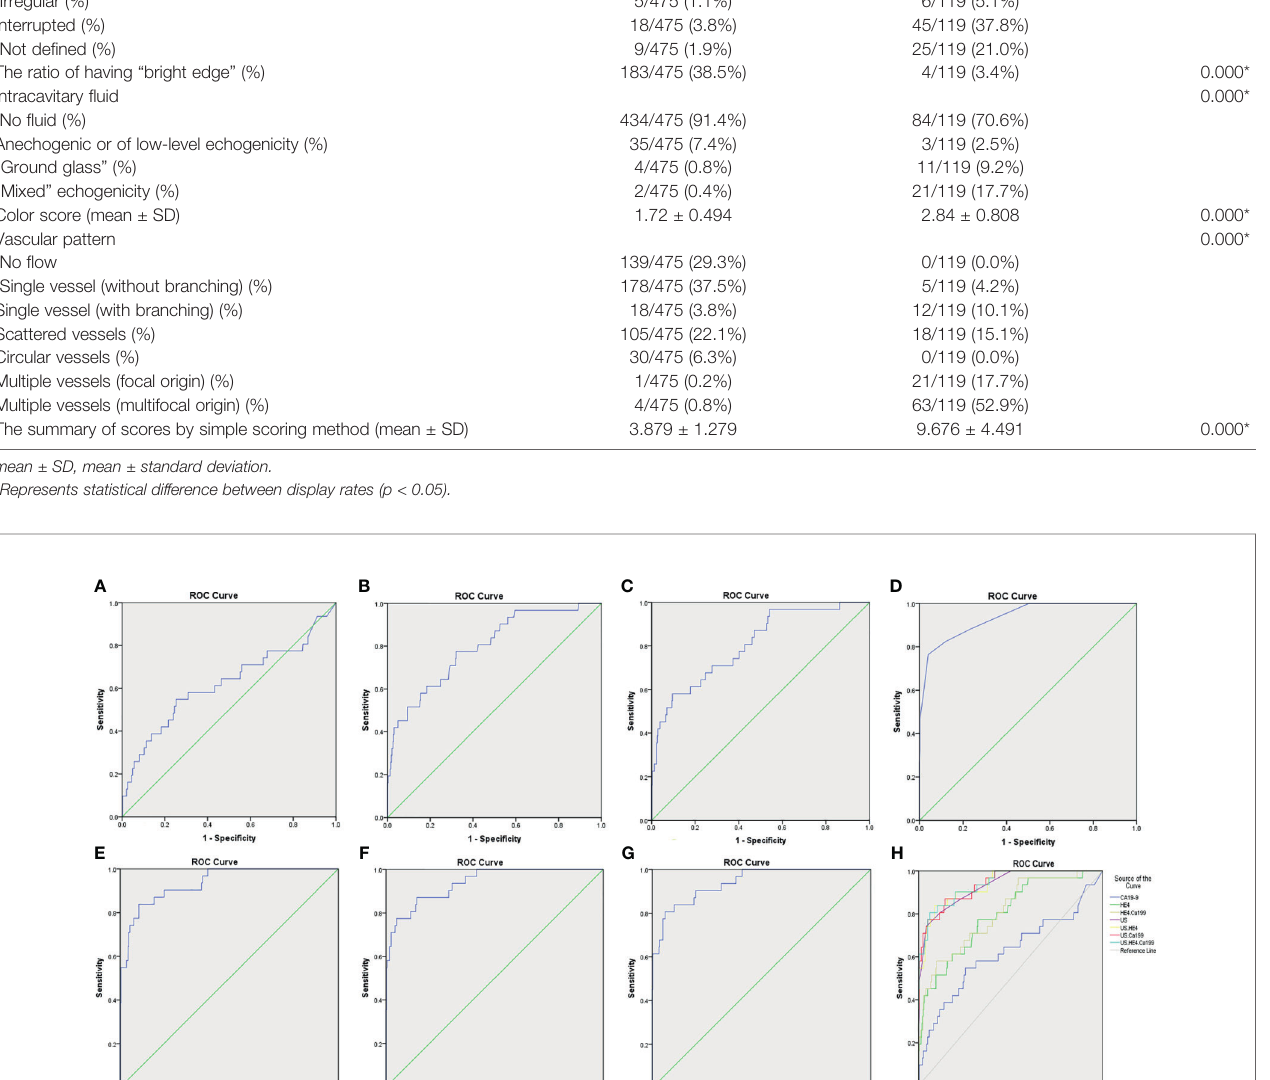
FIGURE 4 | The ROC curves for various diagnostic methods. (A) The ROC curve of tumor biomarker CA19-9. (B) The ROC curve of tumor biomarker HE4. (C) The ROC curve of tumor biomarkers HE4 combined with CA19-9. (D) The ROC curve of US. (E) The ROC curve of US combined with tumor biomarker HE4. (F) The ROC curve of US combined with tumor biomarker CA19-9. (G) The ROC curve of US combined with tumor biomarkers HE4 and CA19-9. (H) The ROC curves for various diagnostic methods, US, IETA ultrasound characteristics simple scoring method; ROC, receiver operating characteristic curves.